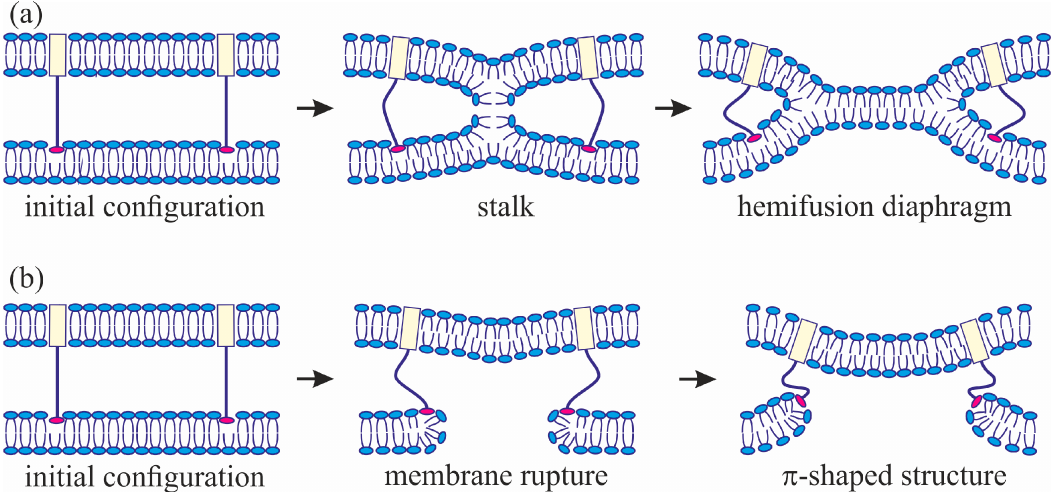
Figure 1. Schematic representation of two scenarios of influenza virus fusion with the host cell membrane: ( a ) a trajectory involving the interim stage of stalk formation, leading to fusion of contact monolayers and formation of a hemifusion diaphragm; ( b ) a trajectory leading to reorientation of the fusion peptides at the edge of the pore and formation of a leaky structure ( π -shaped structure). The viral membrane is on the top, the host cell membrane—at the bottom. Transmembrane domains are represented by light-yellow rectangles, fusion peptides—by red ellipses.